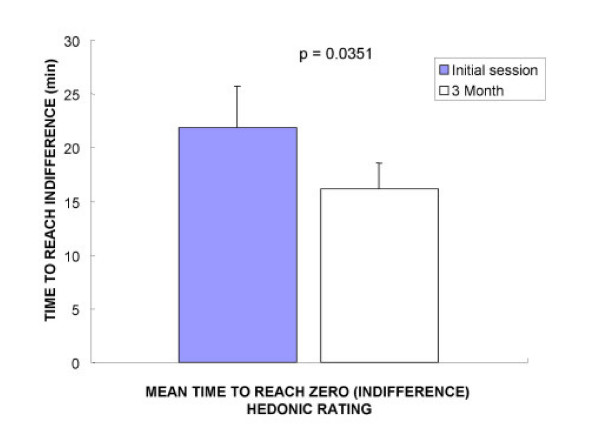
Mean (+/- SE) time to reach zero rating or indifference. The overall time to reach zero rating was significantly decreased after dieting (Initial session 21.9 +/- 3.8; 3 mo 16.2 +/- 2.4 min; Student's paired t = 2.48; p = 0.0351; two tailed).